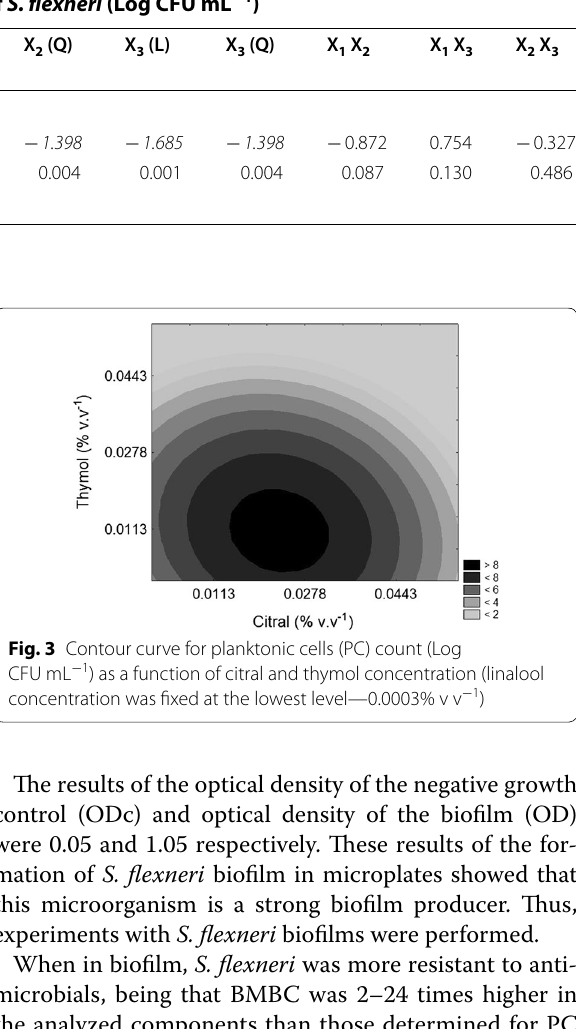
Table 5 Regression coefficients of planktonic cells (PC) count of S. flexneri (Log CFU mL − 1 )